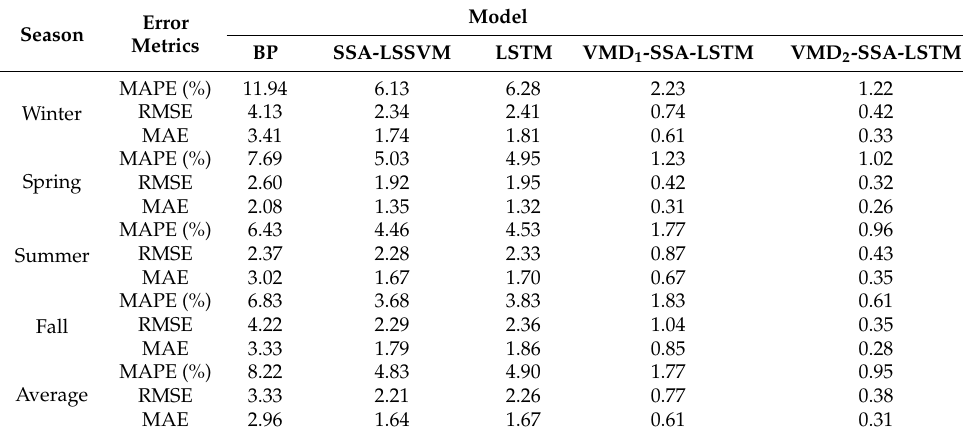
Table 3. Error metrics for different prediction models in Spain.